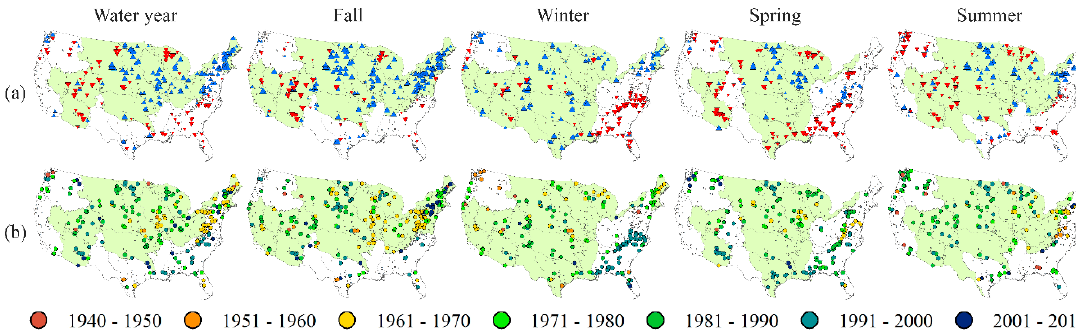
Figure 4. ( a ) Spatial distribution of the stations with shifts across the continental U.S. under Pettitt’s test in water-year and the four seasons ( i.e. , fall, winter, spring and summer). Significant increasing (decreasing) trends are shown by the upward (downward) pointing blue (red) triangles, respectively. The three different sizes of triangles (small, medium, and large) correspond to the confidence level of 90%, 95%, and 99%, respectively. Dots indicate no significant trend; ( b ) spatial distribution of stations with step changes occurring at different time intervals. Each color represents a time interval and the stations showing step changes (both increasing and decreasing) during that particular interval are marked accordingly. Shaded regions (light green) show the presence of field significance.